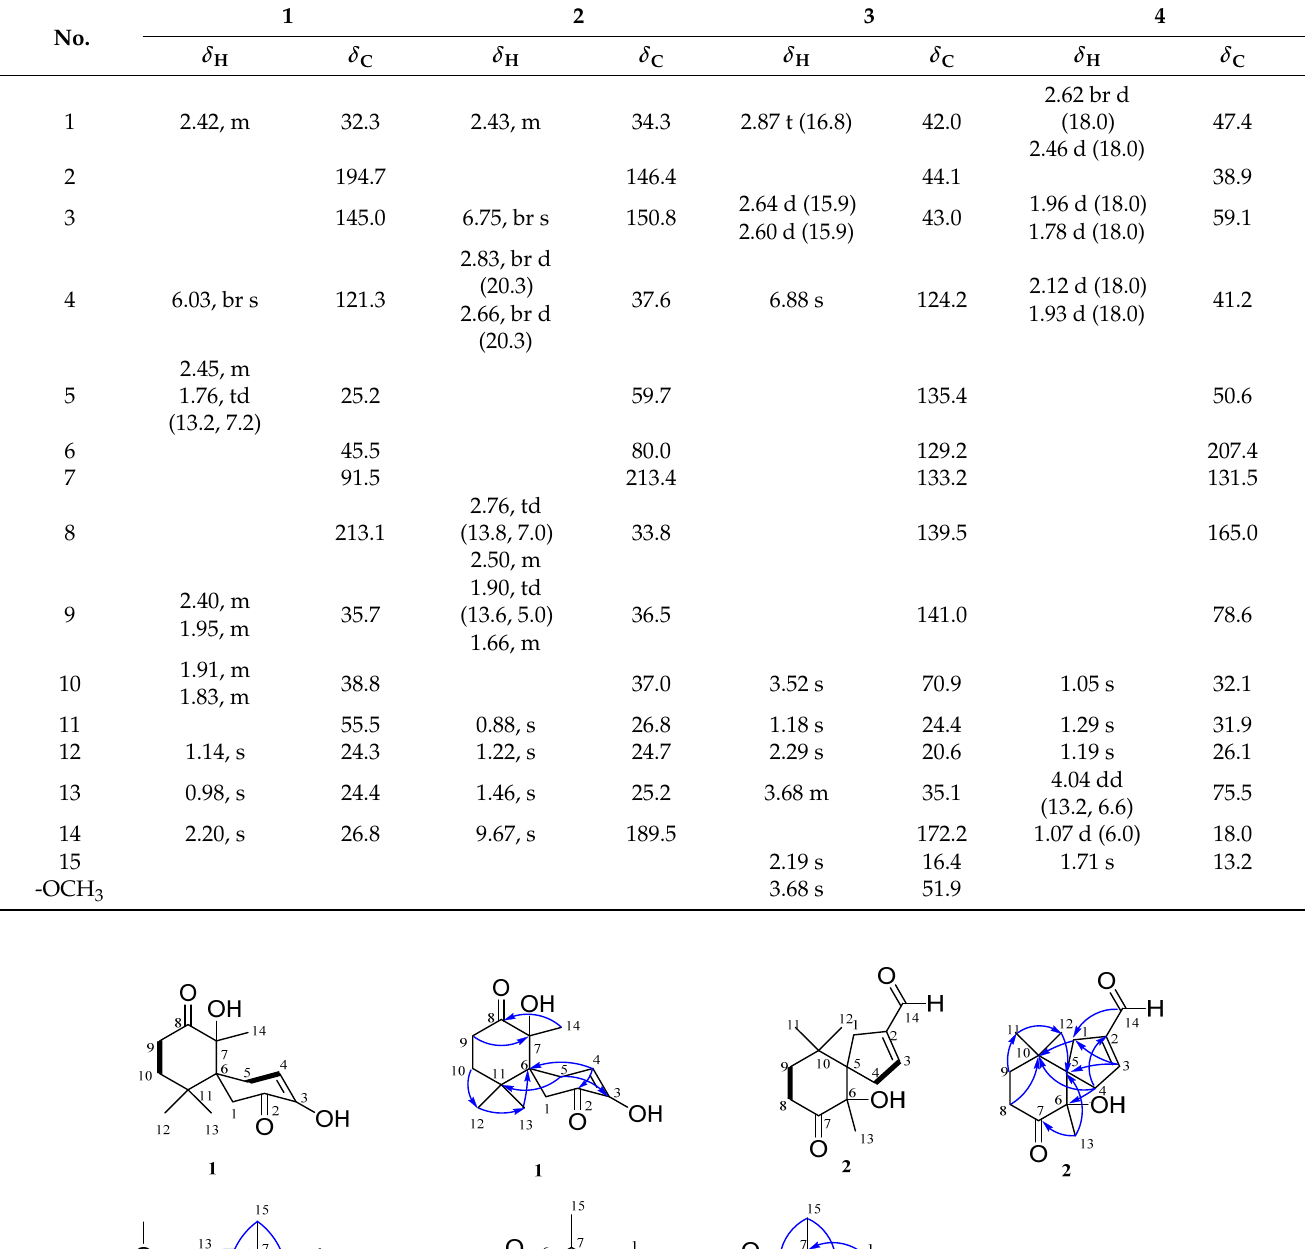
Table 1. 1 H (600 MHz) and 13 C NMR (150 MHz) data for compounds 1 – 3 in CDCl 3 and 4 in CD 3 OD ( δ in ppm, J in Hz).